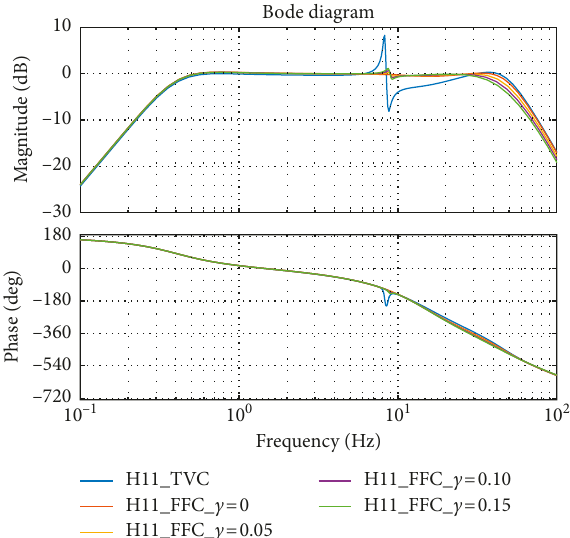
Figure 19: Effect of differential pressure sensor error on the Bode diagram of H 11 .